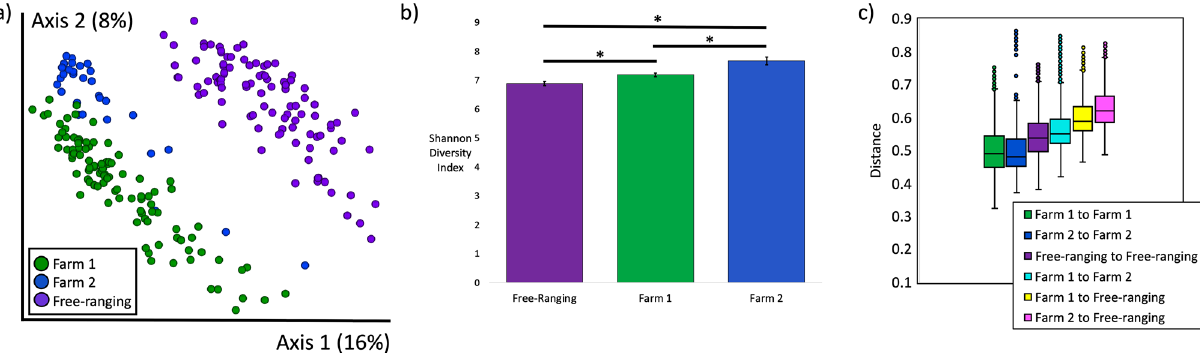
Figure 1. Microbial composition and diversity by provenance. ( a ) Microbial composition (Unweighted UniFrac) differed significantly by provenance (PERMANOVA p = 0.001). ( b ) Microbial diversity as measured by the Shannon Diversity Index differed significantly by provenance ( p = 6.5 × 10 −11 ). All pairwise comparisons * p < 0.001. ( c ) Farmed deer have more similar microbial communities to each other than to free-ranging deer (Unweighted UniFrac pairwise PERMANOVA: Farm 1 to Farm 2 pseudo-F = 9, q = 0.001; Farm 1 to Free- ranging pseudo-F = 38, q = 0.001; Farm 2 to Free-ranging pseudo F = 18, q =